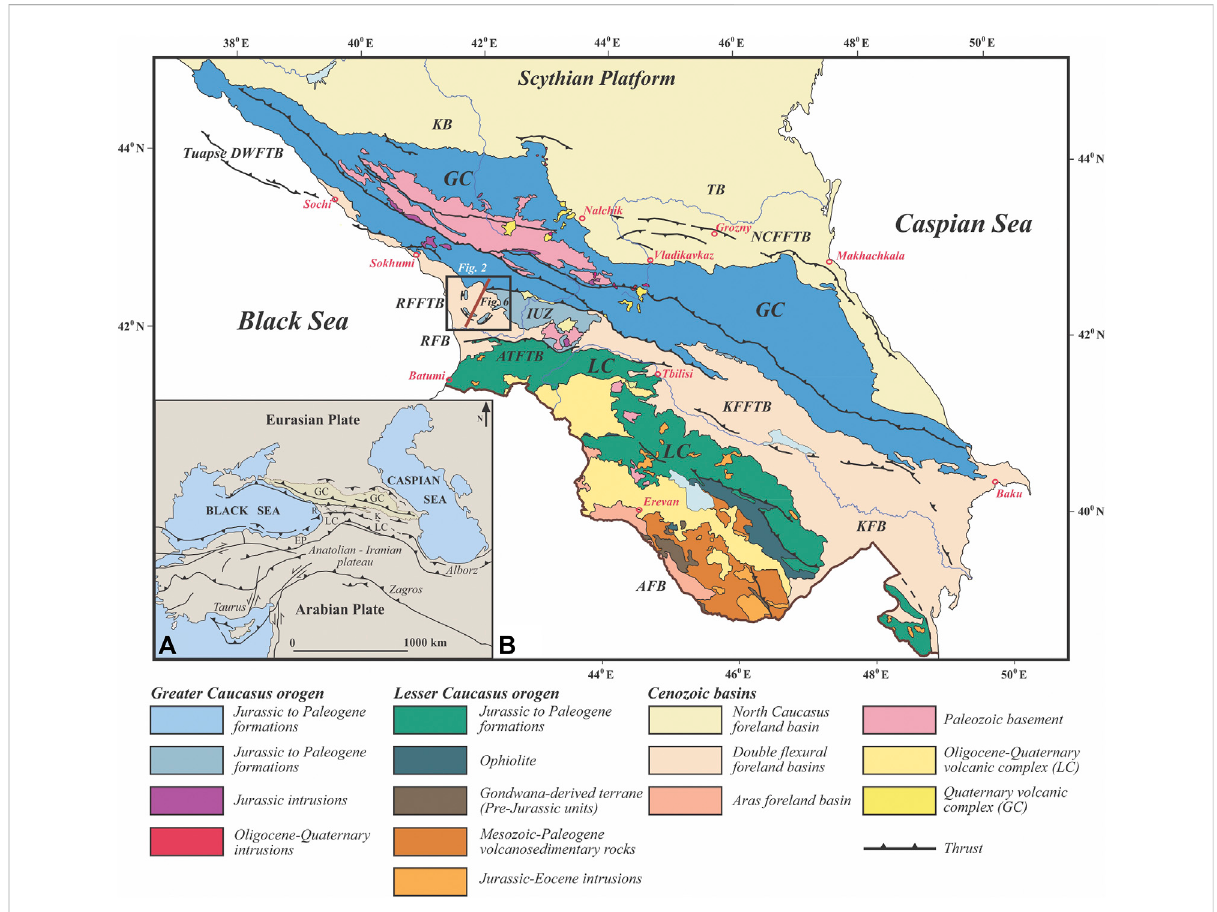
FIGURE 1 (A) Tectonic map of Arabia-Eurasia collision zone (modi fi ed from Sosson et al., 2016). (B) Tectonic map of the Caucasus (modi fi ed from Sobornov, 1996; Adamia et al., 2011a; Sosson et al., 2016; Adamia et al., 2020; Alania et al., 2021a, Alania et al., 2021b; Mosar et al.,